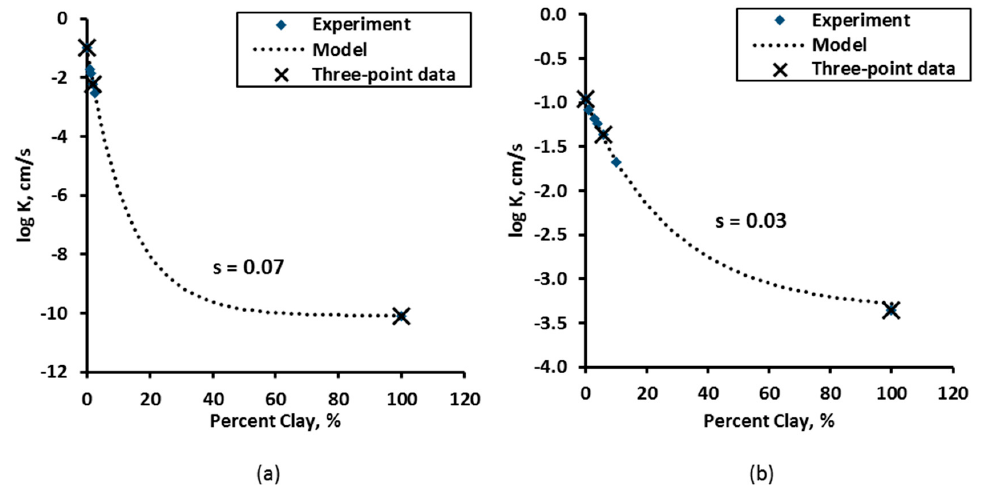
Figure 7. Comparison of our fitted model results with experimental data from Denson et al. [25] for clay-sand mixtures: ( a ) montmorillonite clay, and ( b ) kaolinite clay. The cross symbol is used to identify the data points used in the three-point method discussed in Section 3.5.